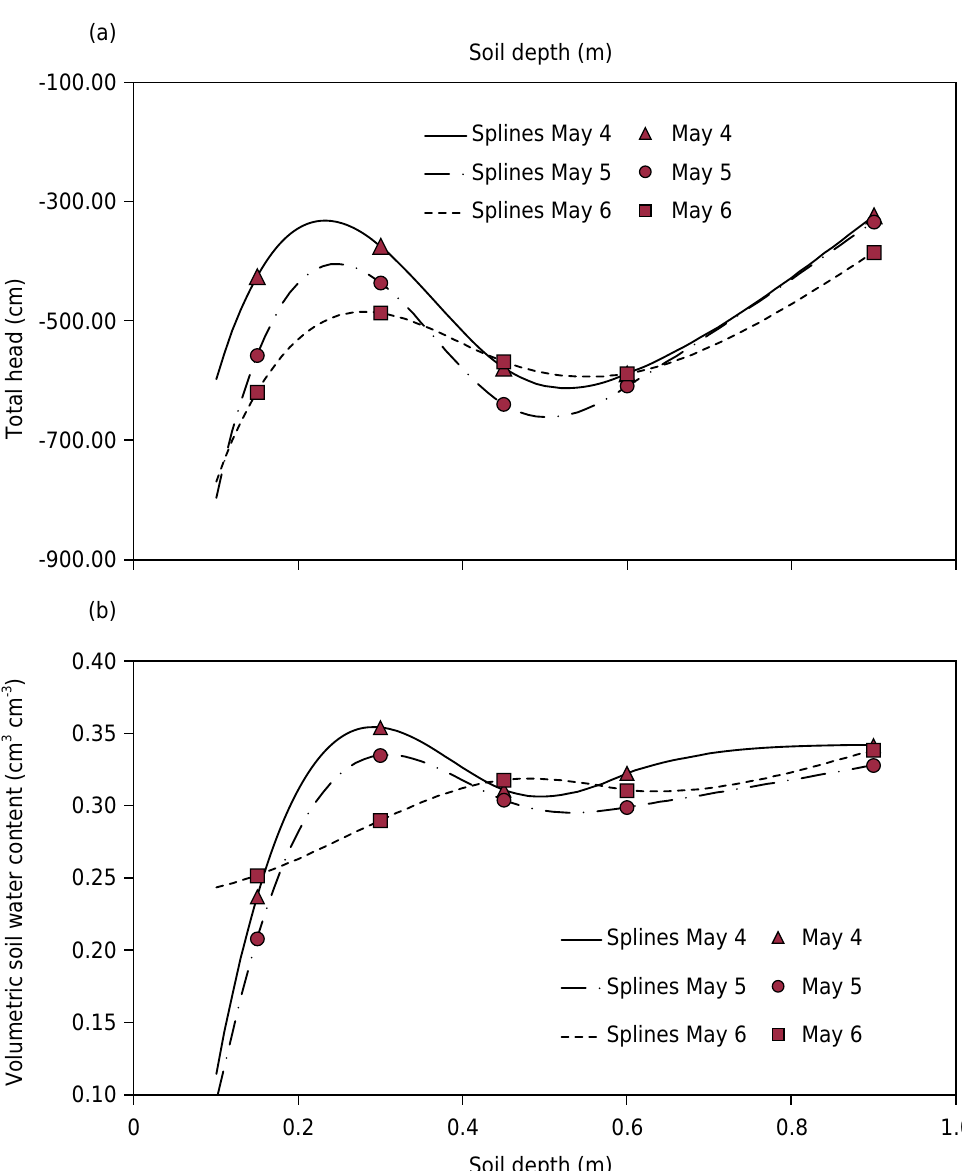
Figure 2. Measured values of total head H (a) and soil volumetric water content θ at different soil depths (b), and cubic splines functions for days 4, 5 and 6 May